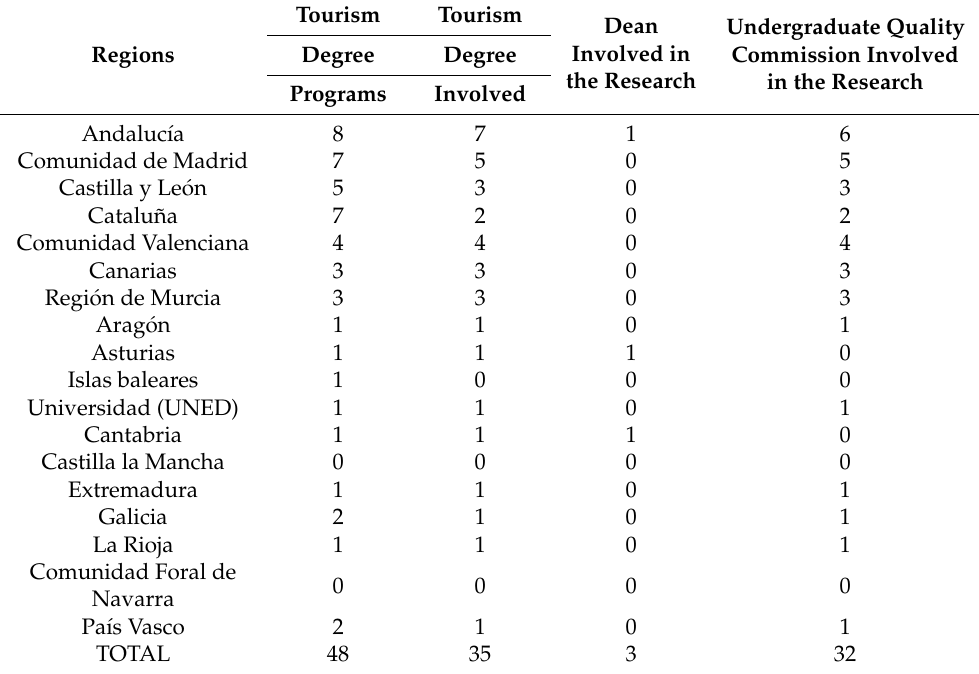
Table 3. Spanish Tourism degree programs’ type of involvement per regions.